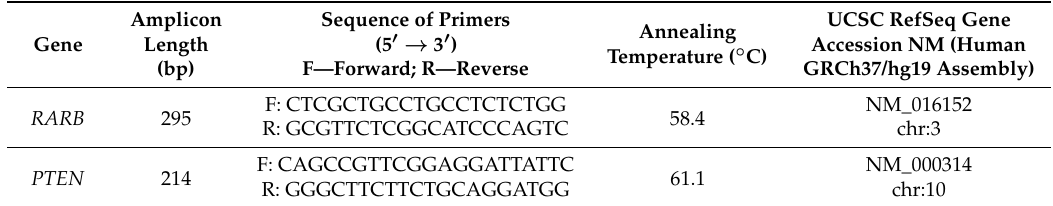
Table 2. Primer sequences, annealing temperature, and polymerase chain reaction (PCR) product size used for methylation-sensitive restriction analysis